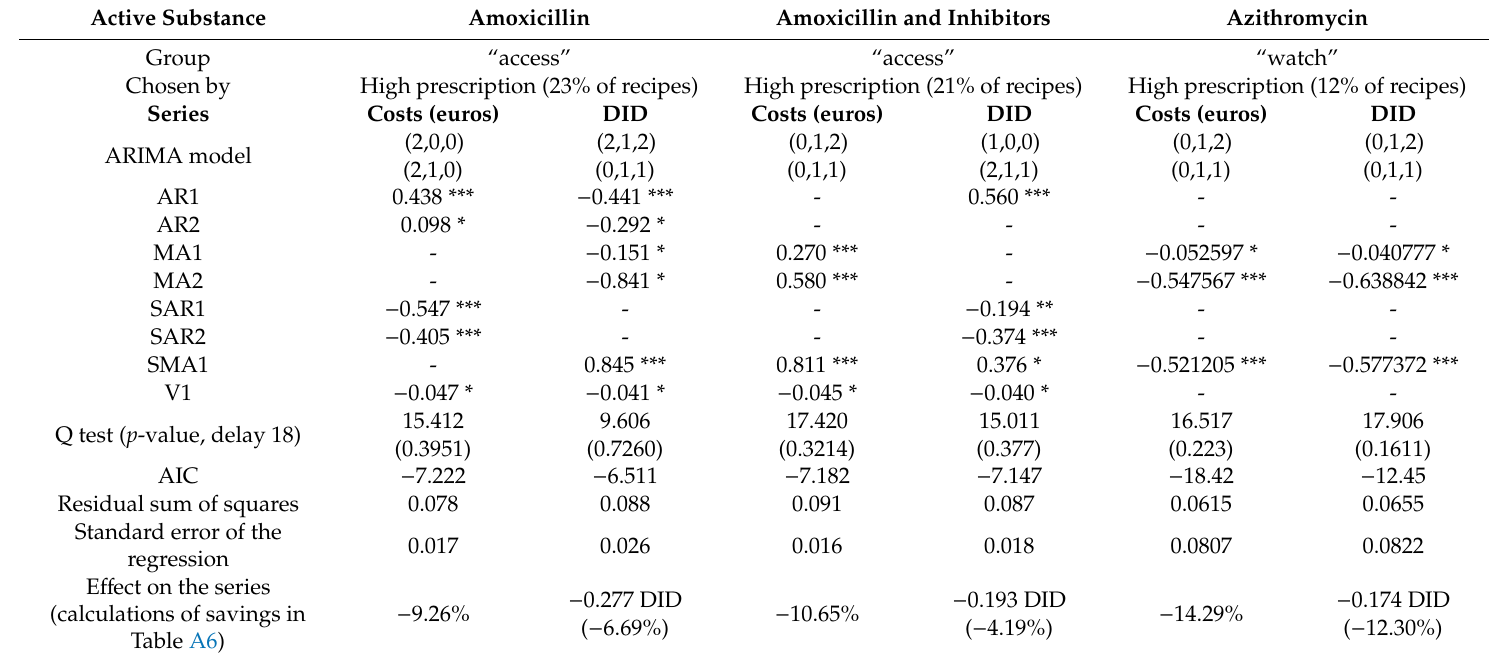
Table A5. Intervention analysis of the costs and DID series by active principle. Real values from January 2009 to June 2015 and predictions from July 2015 to June 2016 with dummy variable V1.